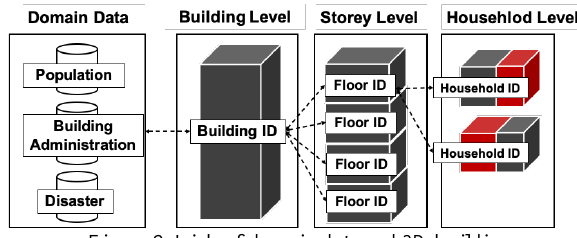
Figure 2. Link of domain data and 3D building